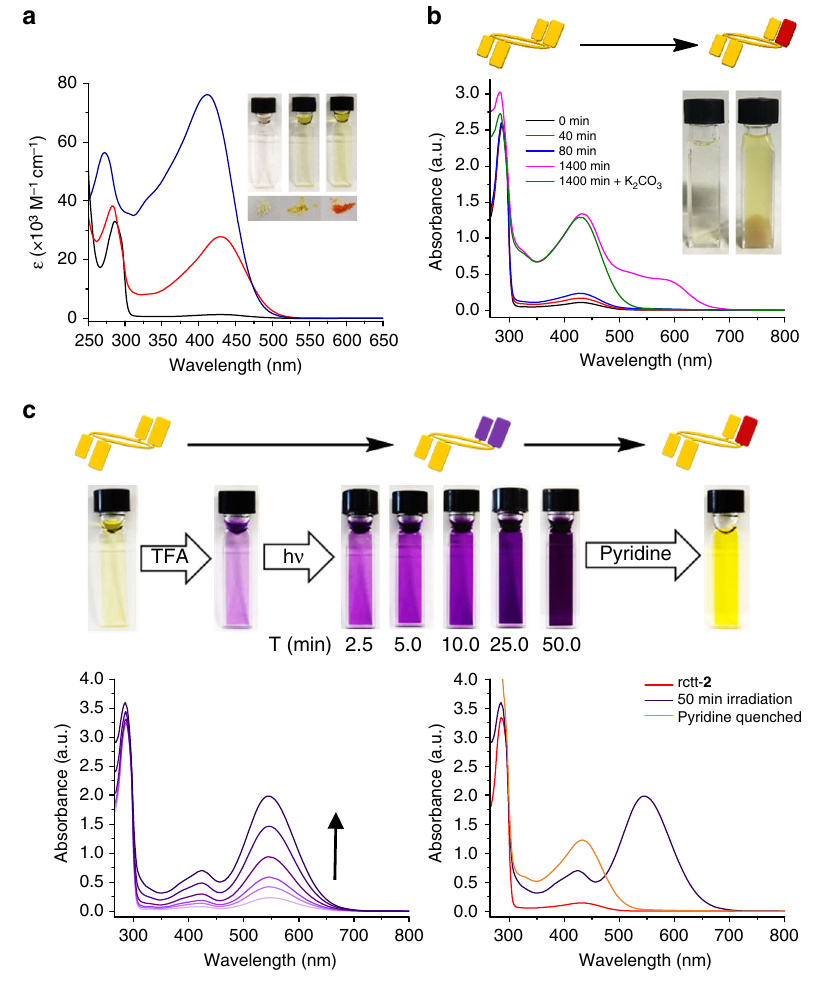
Fig. 3 Variations in electronic absorption spectra during oxidation and hemiquinhydrone formation in 2 series compounds. a Electronic absorption spectra for series 2 compounds: rctt- 2 (black), rctt- 2 -[Ox 1 ] (red), rccc- 2 -[Ox 2 ] (blue) in CHCl 3 at 2.47 × 10 − 5 mol dm − 3 . Inset shows compound colors in solution (upper) and solid states (lower): (left) rctt- 2 , (middle) rctt- 2 -[Ox 1 ], (right) rccc- 2 -[Ox 2 ]. rctt- 2 is white in its native state but turns yellow in air due to the increasing presence of rctt- 2 -[Ox 1 ]. b Electronic absorption spectra of rctt- 2 during photoirradiation at 285 nm under ambient conditions at 9.02 × 10 – 5 mol dm − 3 . Increasing absorbance at 420 nm is due to formation of rctt- 2 -[Ox 1 ]. Band emerging at 600 nm is due to formation of the acid-stabilized charge-transfer (C-T) complex formed as HCl is generated in situ by the ultraviolet (UV)-promoted decomposition of CHCl 3 . c Photooxidation of rctt- 2 (1.02 × 10 − 3 mol dm − 3 ) to rctt- 2 -[Ox 1 ] in CHCl 3 in the presence of tri fl uoroacetic acid (TFA; 10 μ L, fi nal concentration = 8.9 × 10 − 2 mol dm − 3 ) followed by neutralization by addition of pyridine (10 μ L). Photographs of cuvettes illustrate distinct color change from colorless to deep purple then to yellow upon neutralization. UV/visible (vis) spectra (bottom left) reveal emergence of a band at 550 nm and addition of pyridine yields neutral rctt- 2 -[Ox 1 ] (bottom right). Photoirradiation of rctt- 2 gives exclusively rctt- 2 -[Ox 1 ] with no higher oxidation products detectable. The initial purple hue found after addition